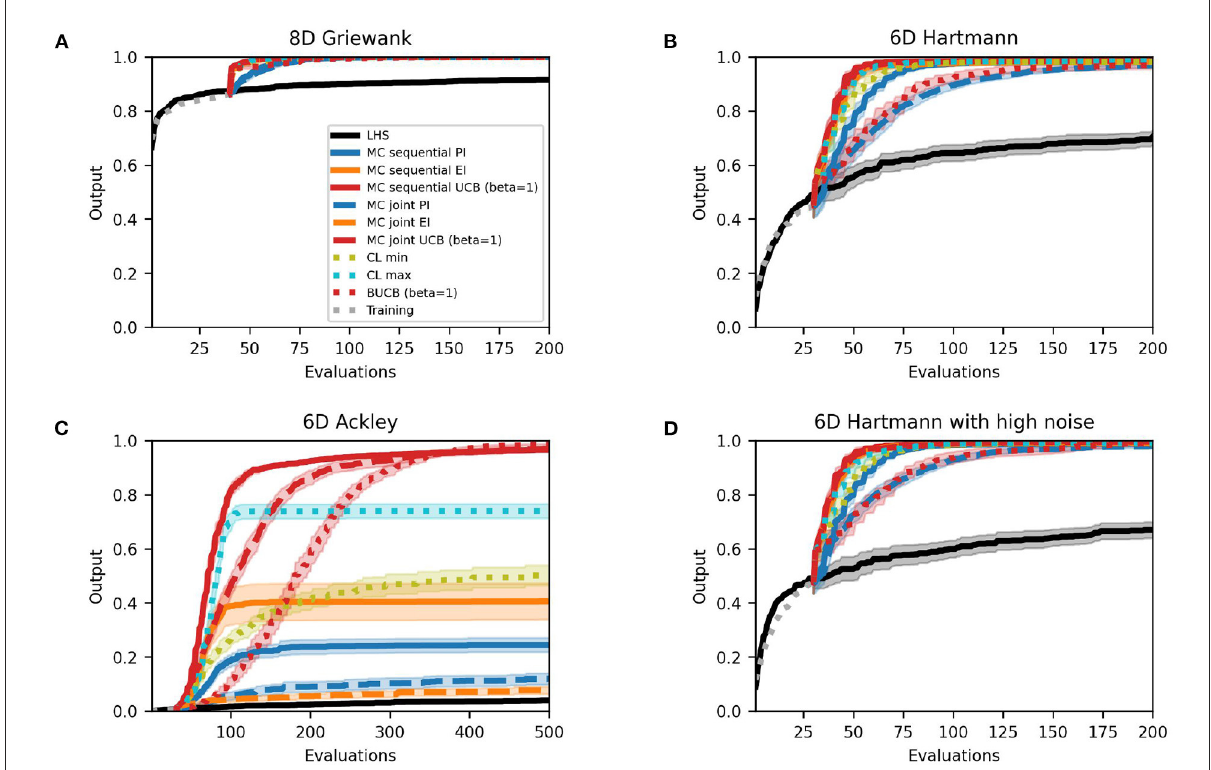
FIGURE6 Performance plots for multi-point acquisition functions with five initial training points per input dimension. Solid lines represent the mean over the 50 runs while shaded areas represent the 95% confidence intervals. PI in blue, EI in orange, UCB in